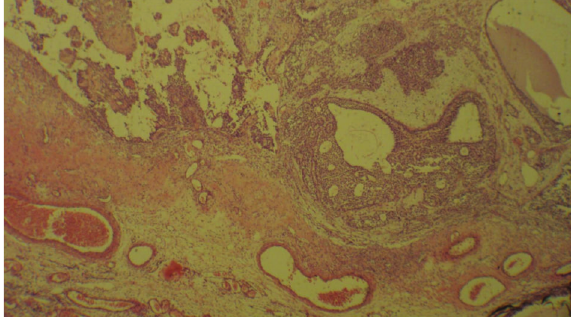
Figure 2: Solid and cystic pattern of the tumor with irregular follicles and pseudopapillary projections (H&E, × 100).